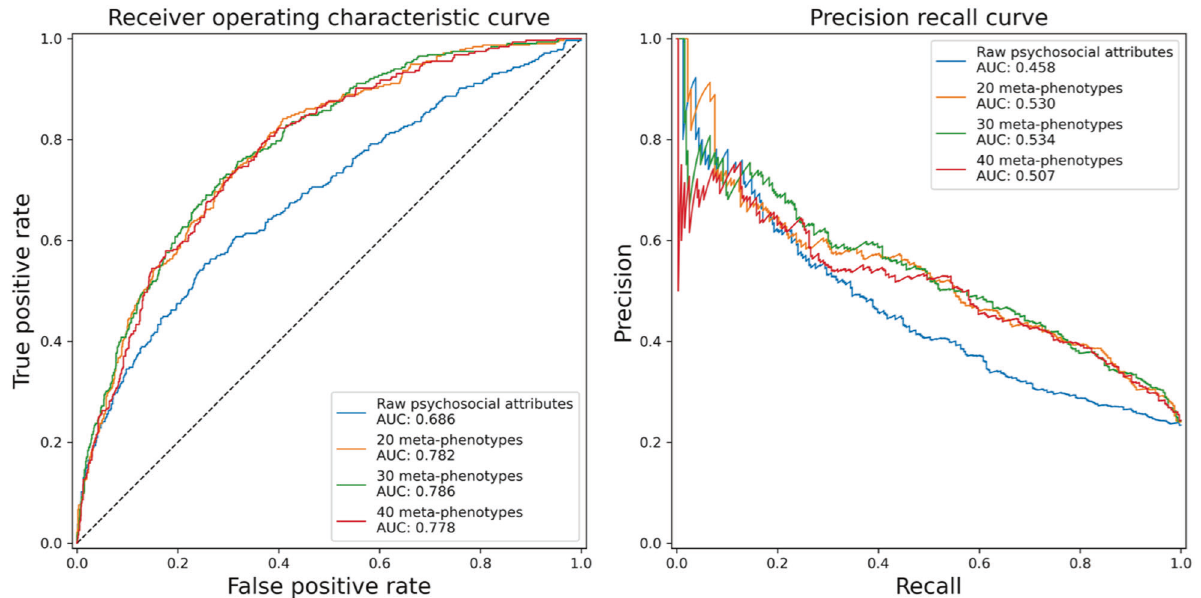
Fig. 3 Classi fi cation accuracy of fi ve-fold cross-validations in AUC curves and AUPRC (MixEHR meta-phenotypes vs. raw psychosocial attributes). AUC area under the receiver operating characteristic, AUPRC area under the precision-recall